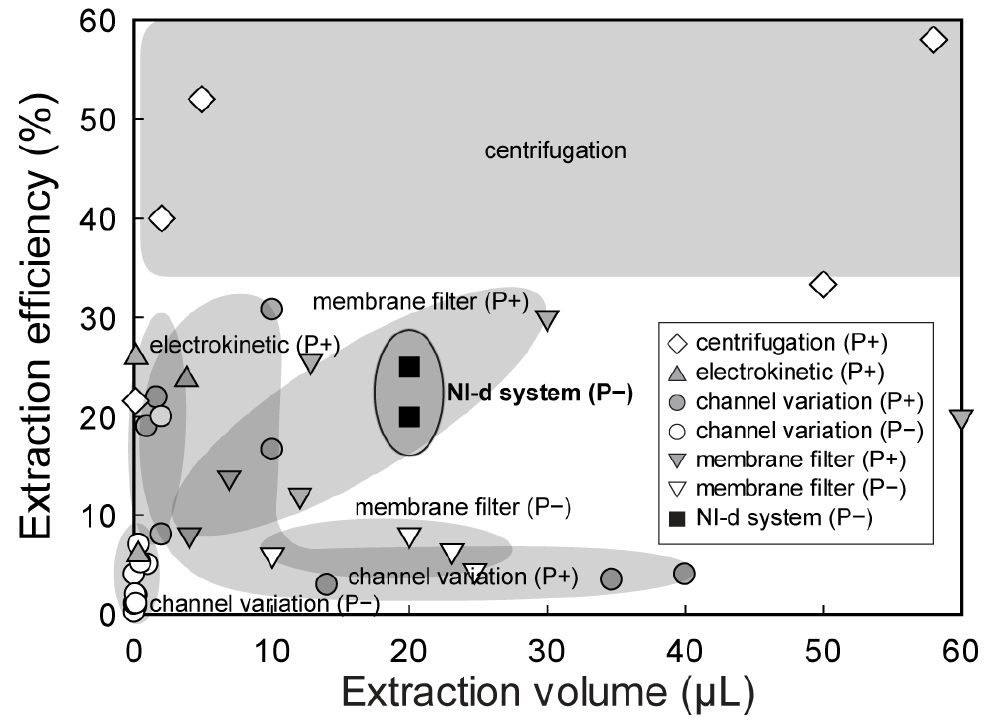
Figure 4. Position of plasma extraction efficiency graph. The solid rectangle represents the developed system. P+: External Power Type, P−: Powerless Type.